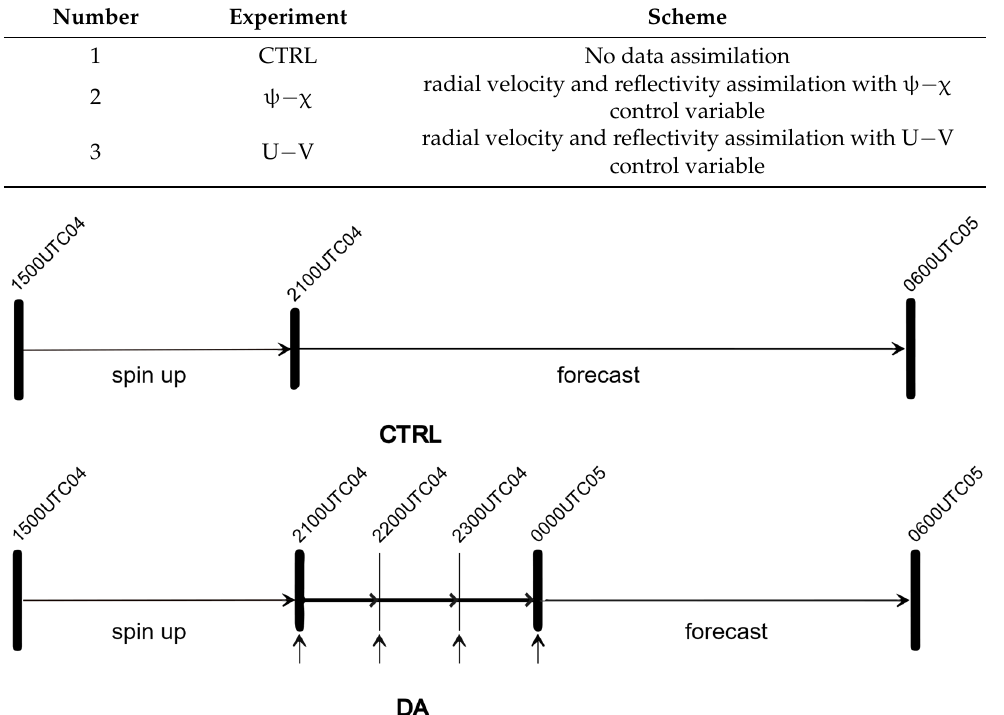
Figure 2. The WRF model domain with the altitude (shade, unit: m) also indicated is the WanZhou radar locations (blue asterisks) and its maximum range coverage circles (blue dotted line). Table 1. Experiment scheme. Table 1. Experiment scheme.